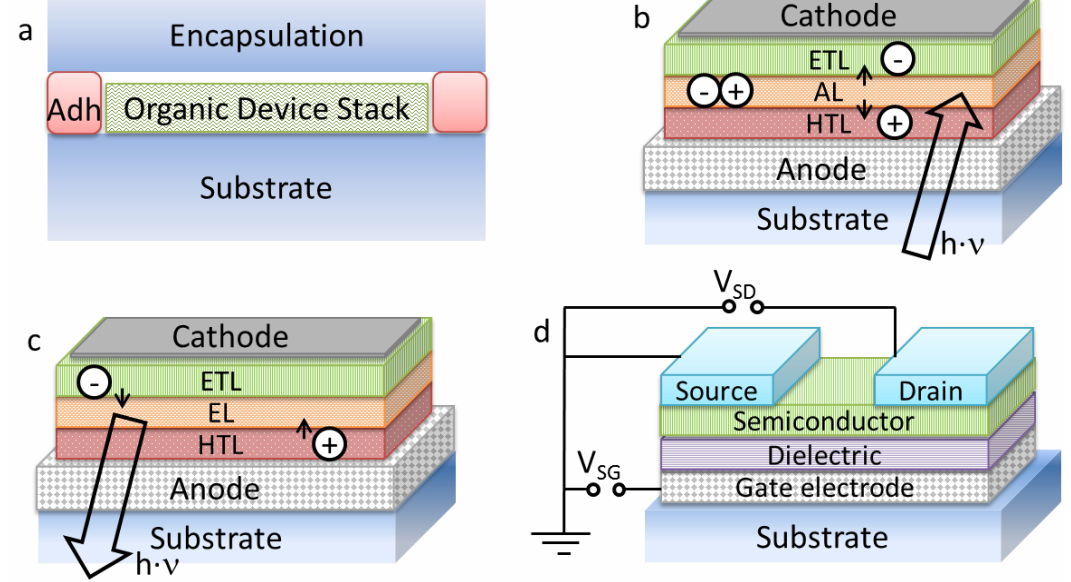
Figure 3. Schematic illustration of ( a ) the cross section of an organic device consisting of an organic device stack deposited on a substrate, encapsulated with a barrier material that is fixed with an adhesive (Adh). The composition of the organic device stack defines the properties of an OSC ( b ), an OLED ( c ), or an OTFT ( d